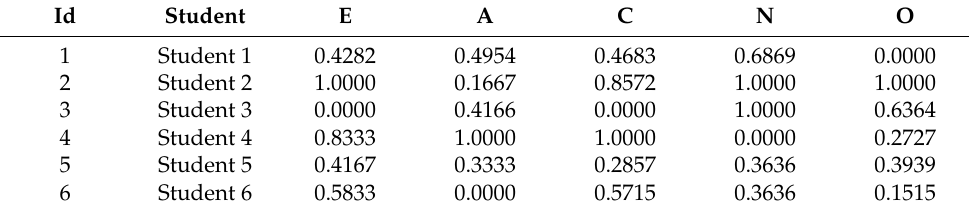
Table 5. Scaled values.